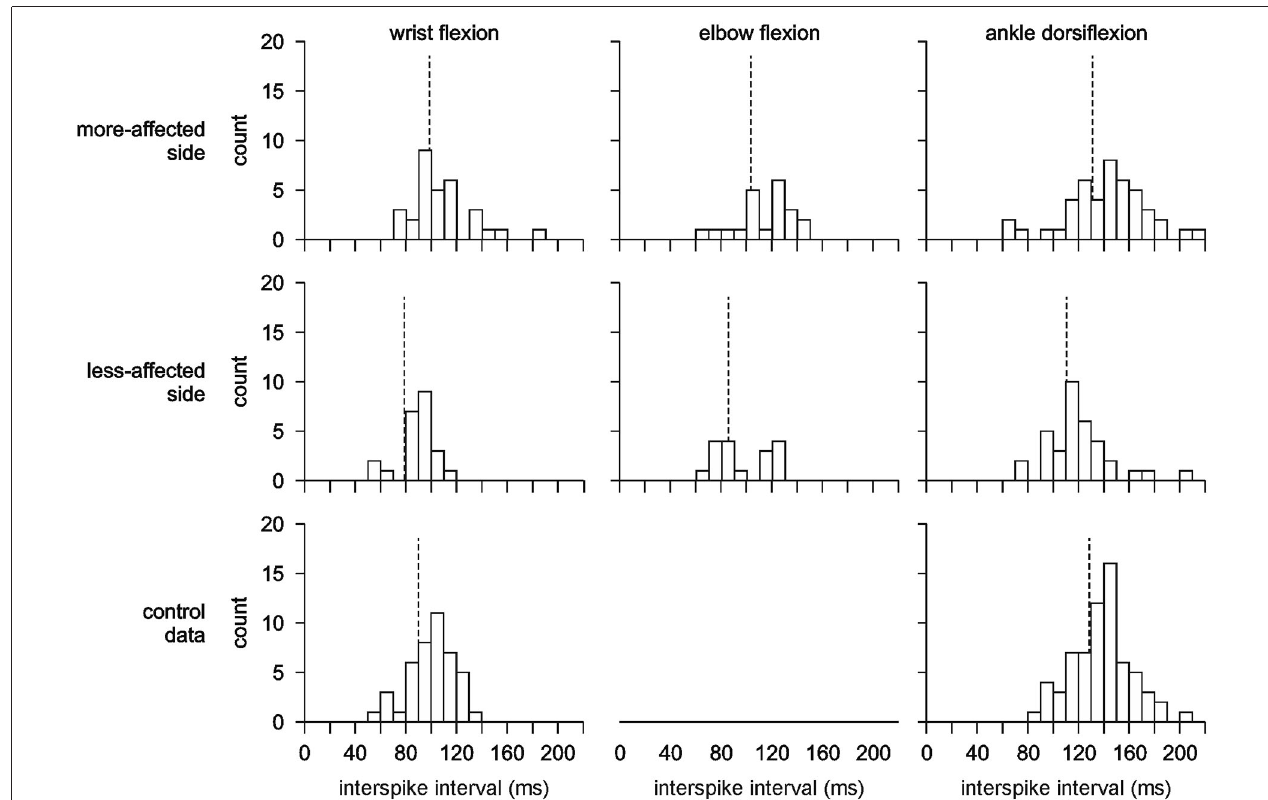
compared to the more-affected side and control data. The vertical dash line indicates the mean for each histogram. Note that no control data was recorded for elbow